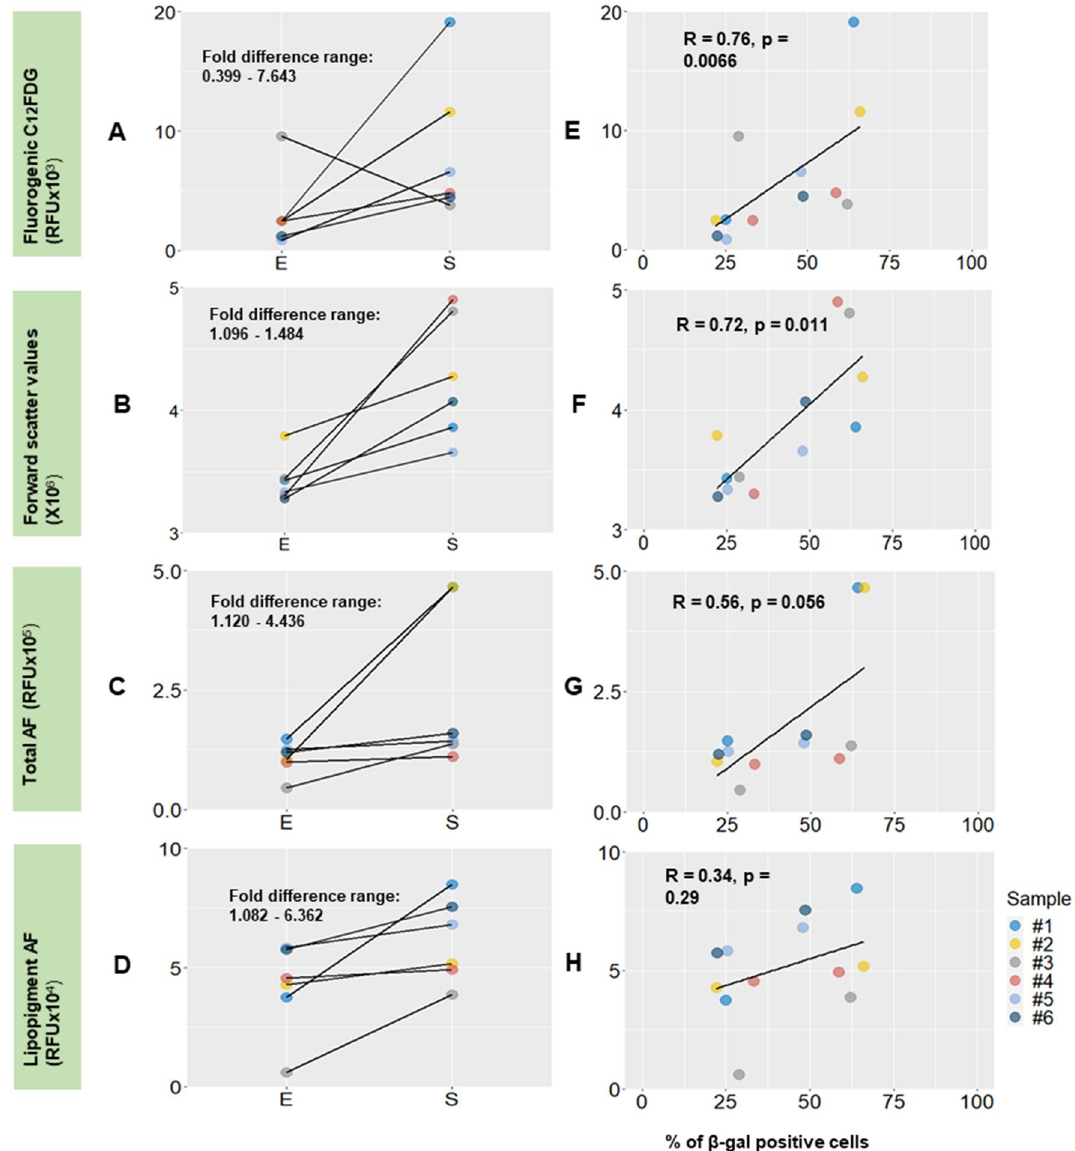
staining through C 12 FDG mean ( B ) forward scatter mean ( C ) total autofluorescence mean ( D ) lipopigment autofluorescence mean. E—early, S—senescent passages. Spearman’s correlation coefficient, a statistical measure of the strength of a monotonic relationship between paired data, was employed to benchmark the various autofluorescence and flow cytometry methods with β